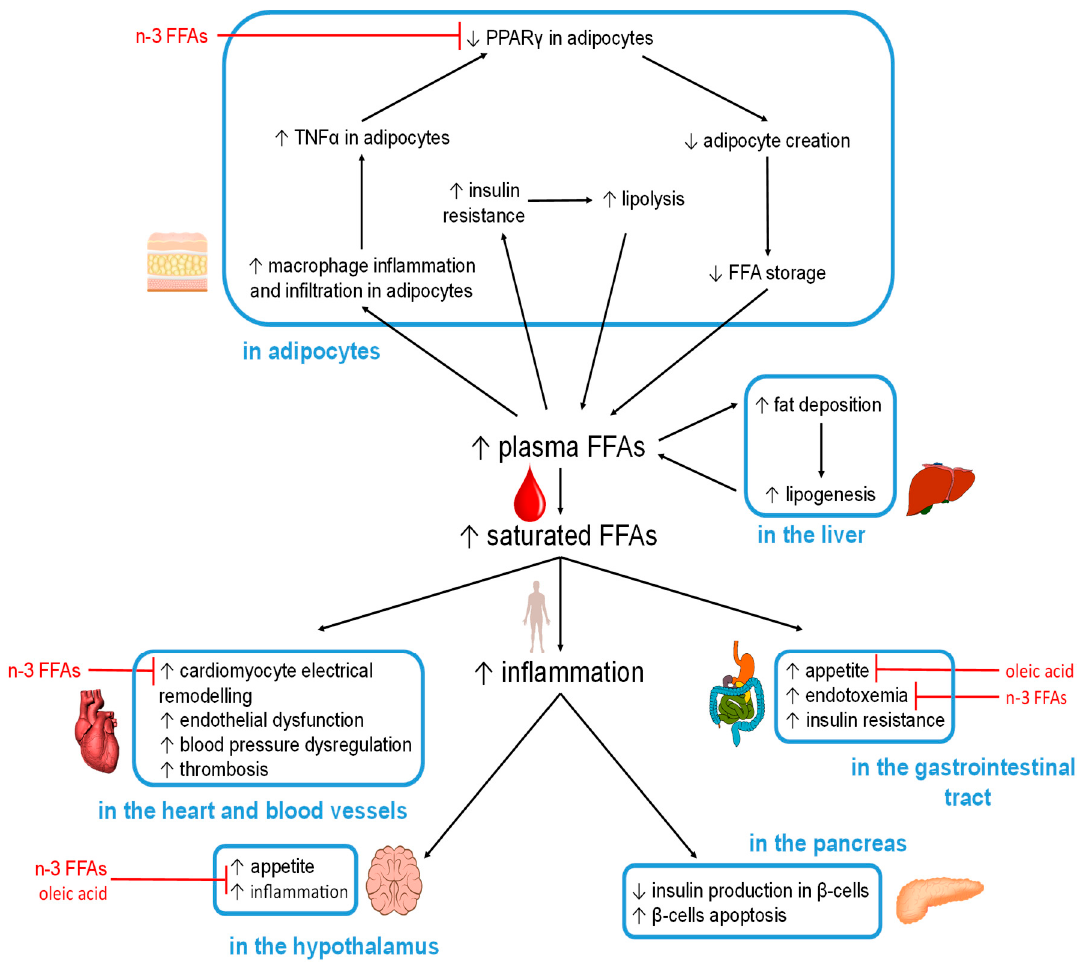
Figure 2. Schematic summarizing the organ-specific effects of excess FFAs and saturated FFAs on metabolism and the different mechanisms through which insulin resistance can occur. FA (fatty acids); FFA (free fatty acids); PPAR (peroxisome proliferator-activated receptors); TNF α (tumour necrosis factor α ).